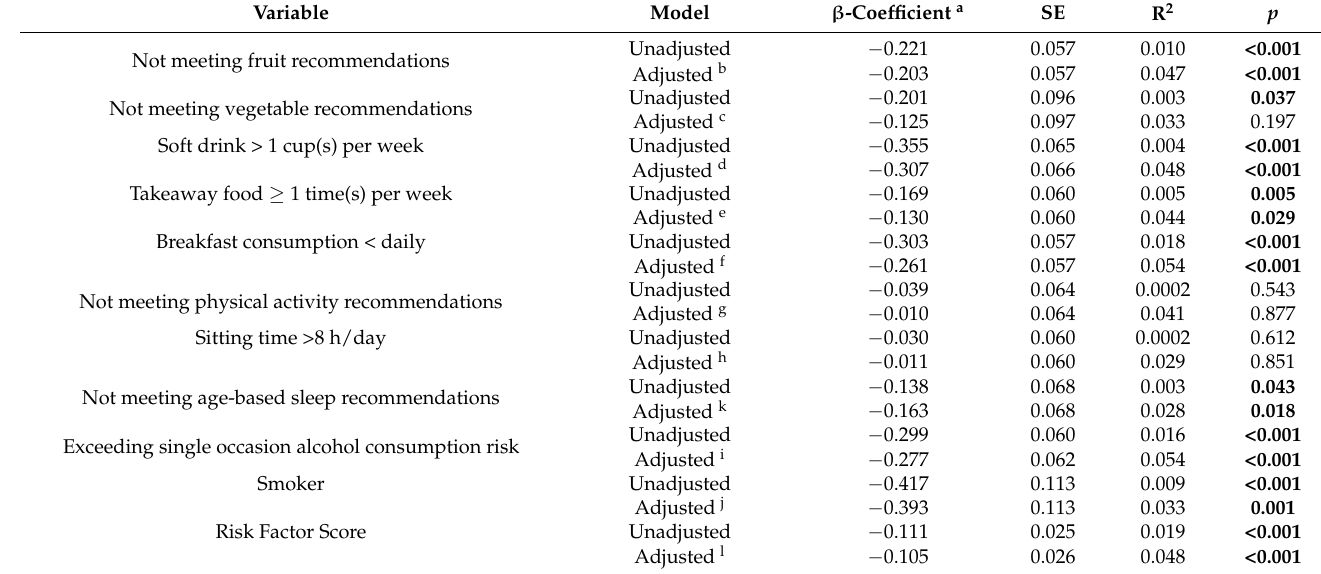
Table 3. Linear regression results of academic achievement (GPA) with health risk behaviours, adjusted for socio- demographic and student characteristics in a sample of Australian university students ( n =